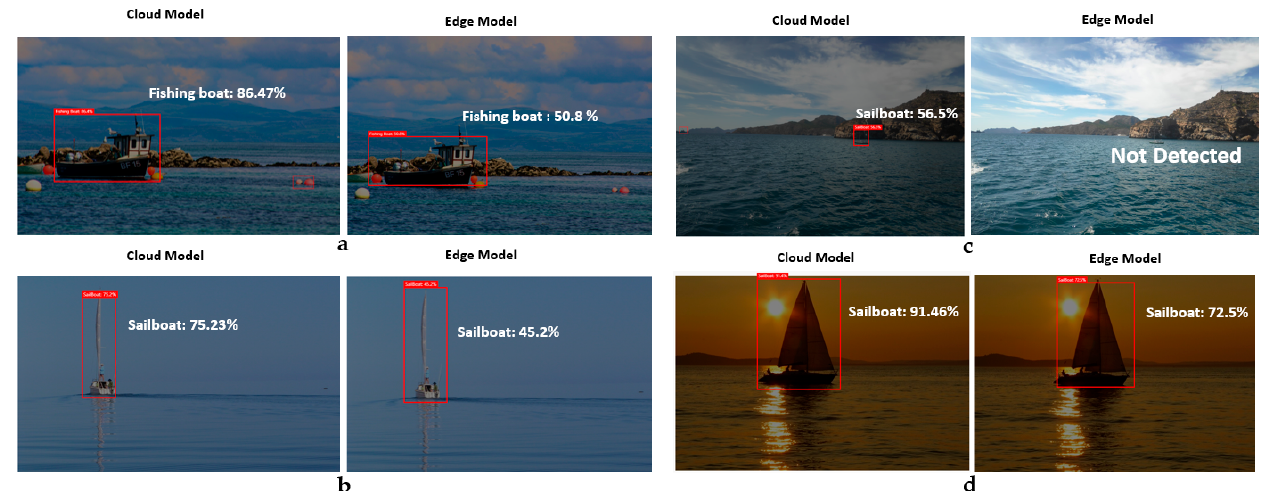
Figure 9. Cloud and edge custom models for detecting new vessels. (( a ): Fishing boat, ( b ): Sailboat, ( c ): Sailboat, ( d ): Sailboat).